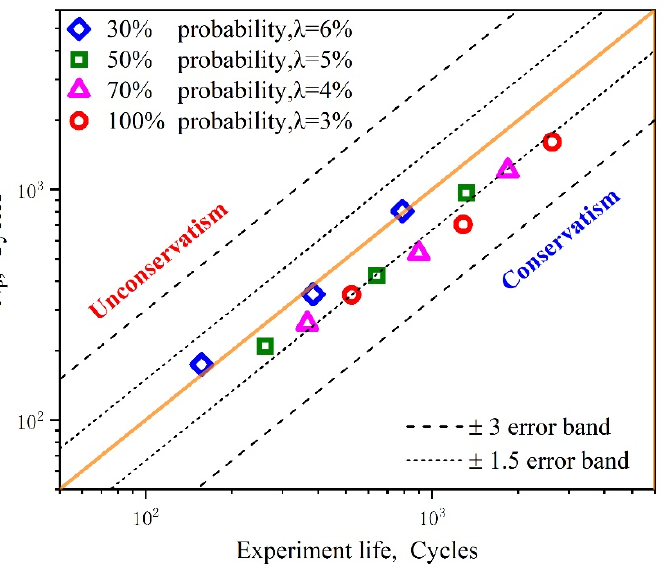
Figure 16. Comparisons between the experimental and predicted small crack propagation life based on the microscale multiaxial FIP P with respect to four probabilities.